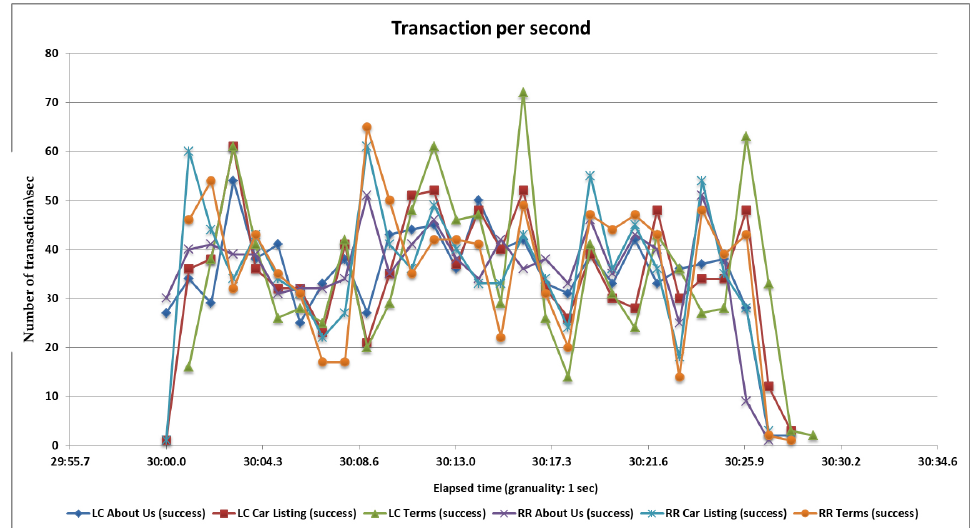
Figure 15. Throughput or transactions per second of the RR and LC algorithms.